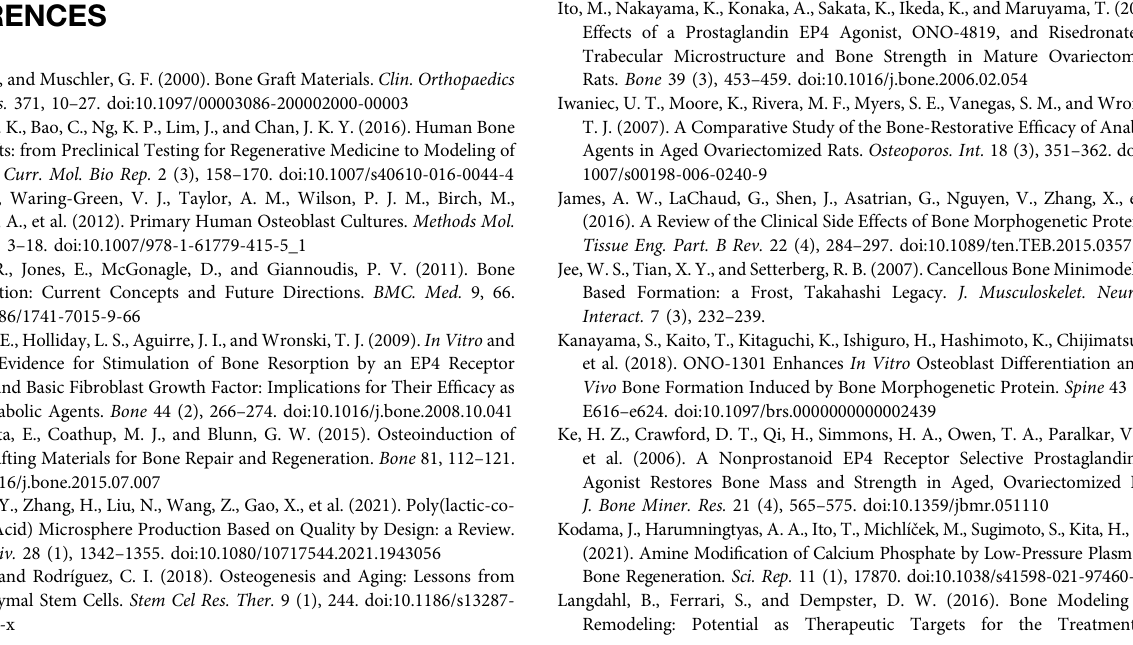
Supplementary Figure S1 | Extraction of new bone formation area Representative images ofxenografted bone in theAKDS001 MSgroup. (A) HE staining. (B) Original microcomputed tomography (CT) image. (C) Color map CT image based on Houns fi eld unit values. (D) Extracted new bone formation area by analysis processing. Scale bars, 100 μ m. (E) Color map CT image (upper) and new bone formation area (lower) of Figure 3A . Scale bars, 1 mm. Supplementary Figure S2 | Representative images of immunostaining using anti- human vimentin, anti-human osteocalcin, anti-rat osteocalcin for rat femur and human vertebral lamina. Scale bars, 200 μ m. Supplementary Figure S3 | Vascularization in xenografts Hematoxylin and eosin (HE) staining at low magni fi cation (upper) and high magni fi cation (center), and CD31 immunostainingathighmagni fi cation(lower).Scalebars,500 μ m(lowmagni fi cation) and 100 μ m (high magni fi cation). Supplementary Figure S4 | Off-targets of AKDS001 (1) Off-target effects on G protein-coupled receptor, transporters, ion channels, and nuclear receptors by AKDS001. Supplementary Figure S5 | Off-targets of AKDS001 (2) Off-target effects on kinases, other non-kinase enzymes by AKDS001. Supplementary Figure S6 | Evaluation of pathways involved in the osteogenic effects of AKDS001 (A) ALP activity of hMSCs treated with or without AKDS001 (100 nM) and PKA inhibitor, H89 (5, 10, 20 μ M). n = 3 per group. (B) ALP activity of hMSCs treated with or without AKDS001 (100 nM) and PI3K inhibitor, wortmannin (20,100,500 nM). n =3pergroup. (C) ALPactivityofhMSCstreatedwithorwithout dibutyryl-cAMP (db cAMP) (0.5, 1, 2 mM). n = 3 per group. * p < 0.05, ** p < 0.01 by Dunnett ’ s test. ns: not statistically signi fi